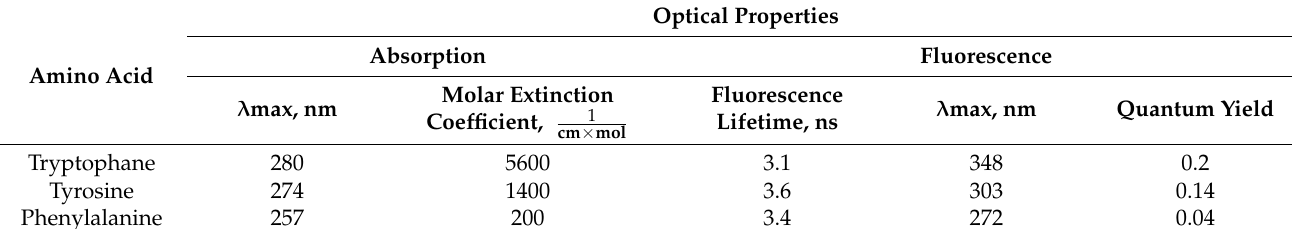
Table 2. Aromatic amino acids absorption and fluorescence [160,161].